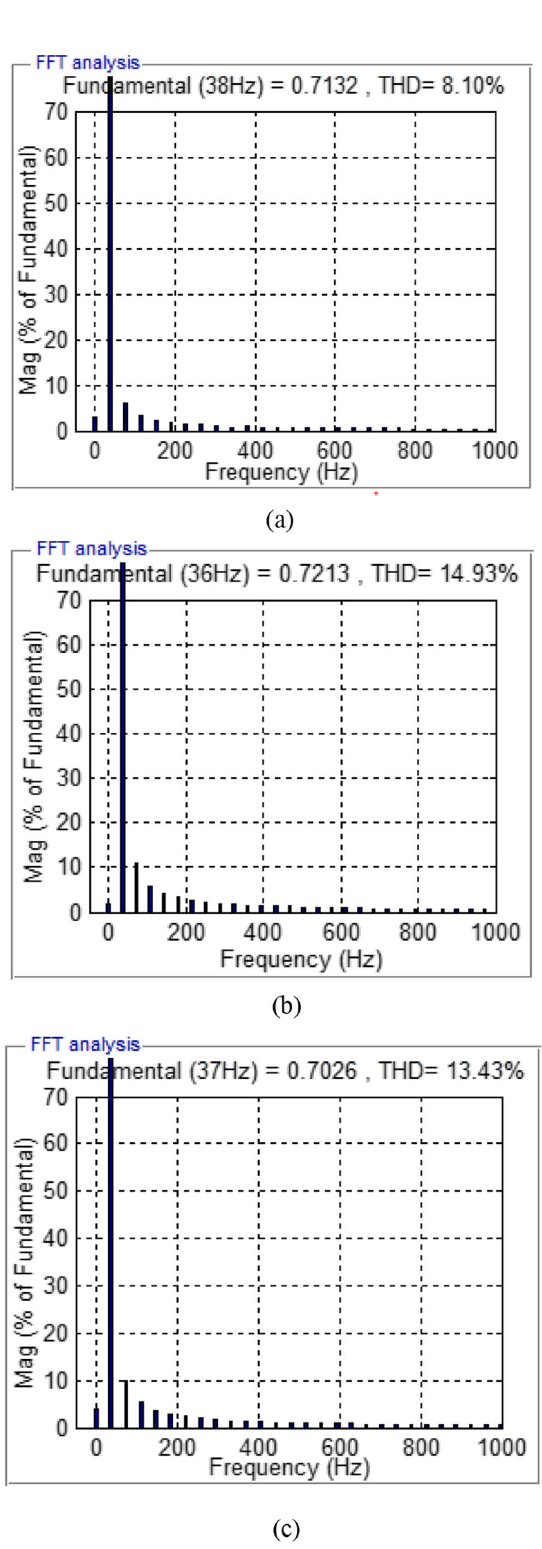
Fig. 10 Harmonic spectra of the stator current (A) ( a ) for M- DTC with a three-level NPC inverter, ( b ) for SM-DTC with a two- level inverter and ( c ) for PI-DTC with a three-level NPC inverter